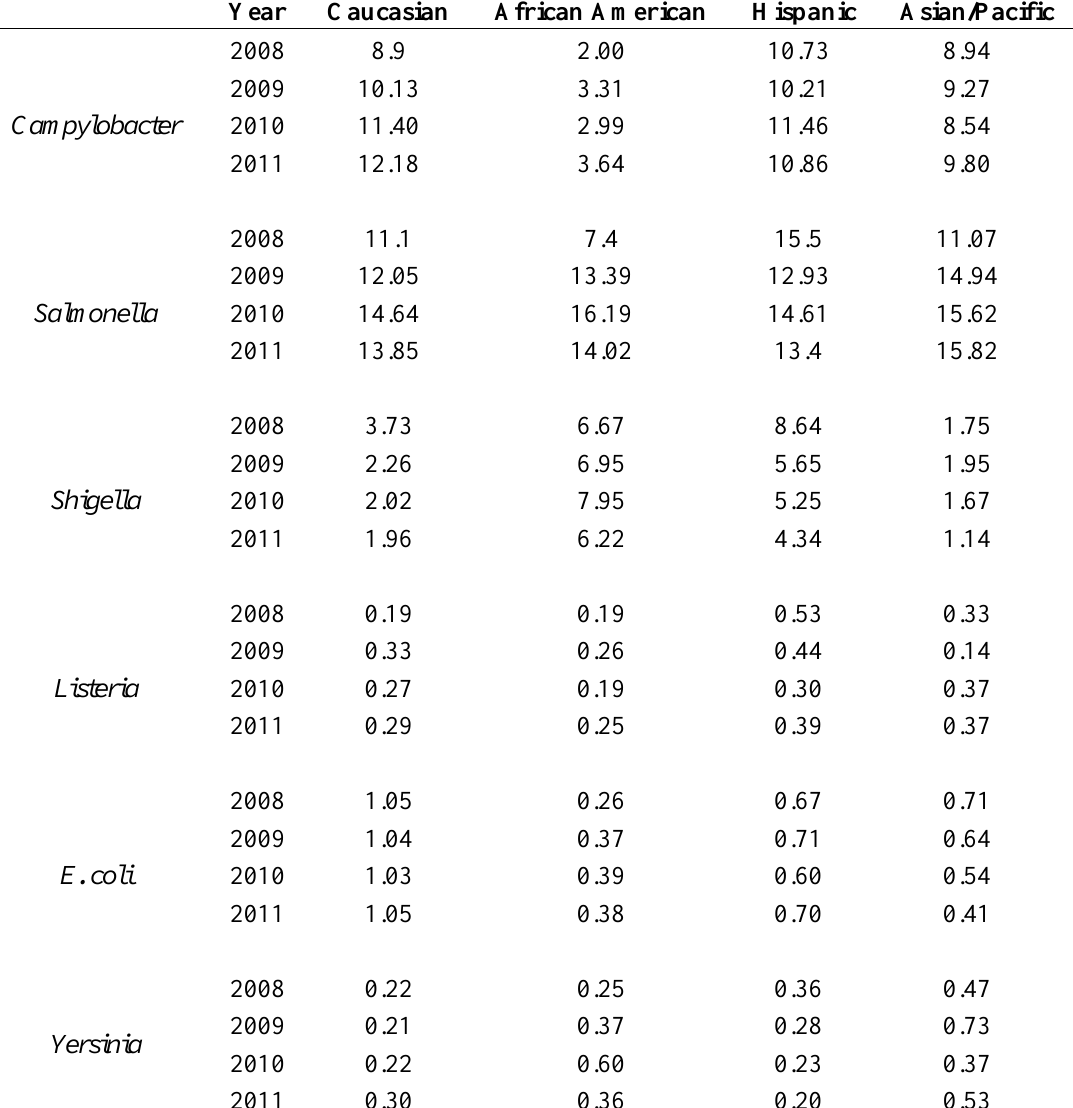
Table 1. Incidence rates (per 100,000 population) of bacterial causes of foodborne illness by race and ethnicity from 2008–2011 (data obtained from FoodNet Final Reports 2008– 2011